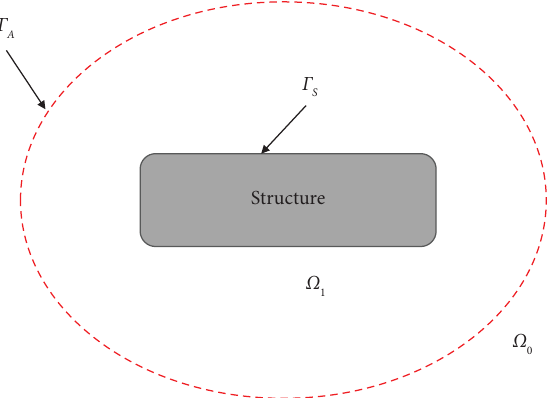
Figure 2: Te geometry of the structural acoustic problem of the FE-FE-BE